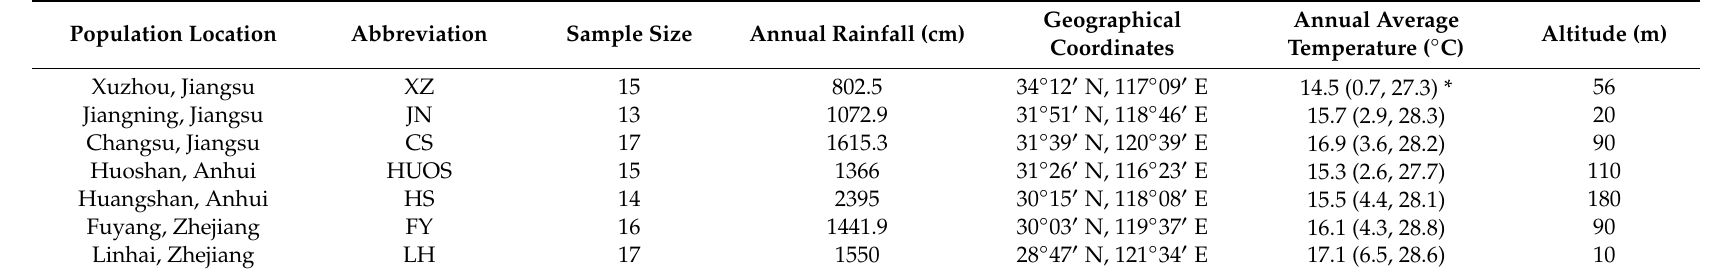
Table 1. Population details of Chinese elms and their climate